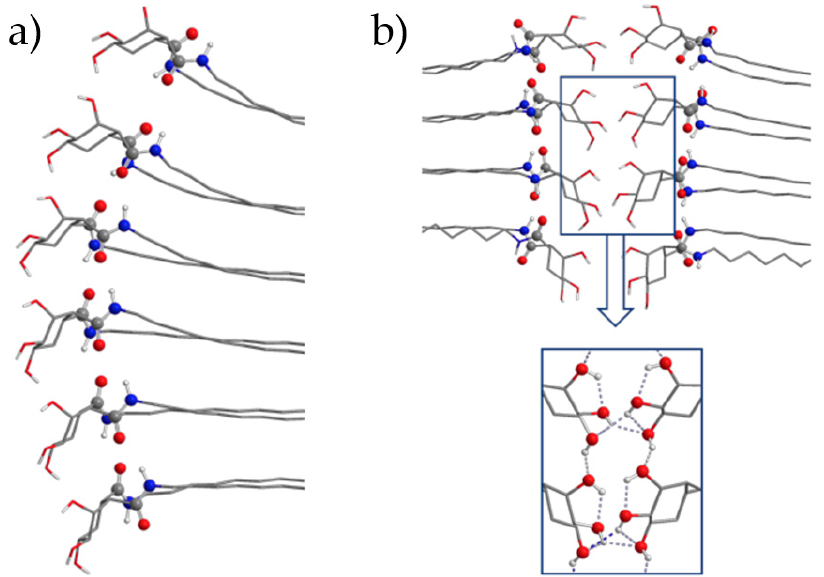
Figure 8. ( a ) side view of central 6 molecules in octameric 1-D aggregate (amide hydrogen-bonds) 5- α . ( b ) side views of octameric 2-D aggregates (amide and hydroxyl hydrogen-bonds) 5- β . Non-polar hydrogen atoms have been omitted for clarity. Atoms in amide groups have been represented with red (oxygen), blue (nitrogen) and grey (carbon) spheres.